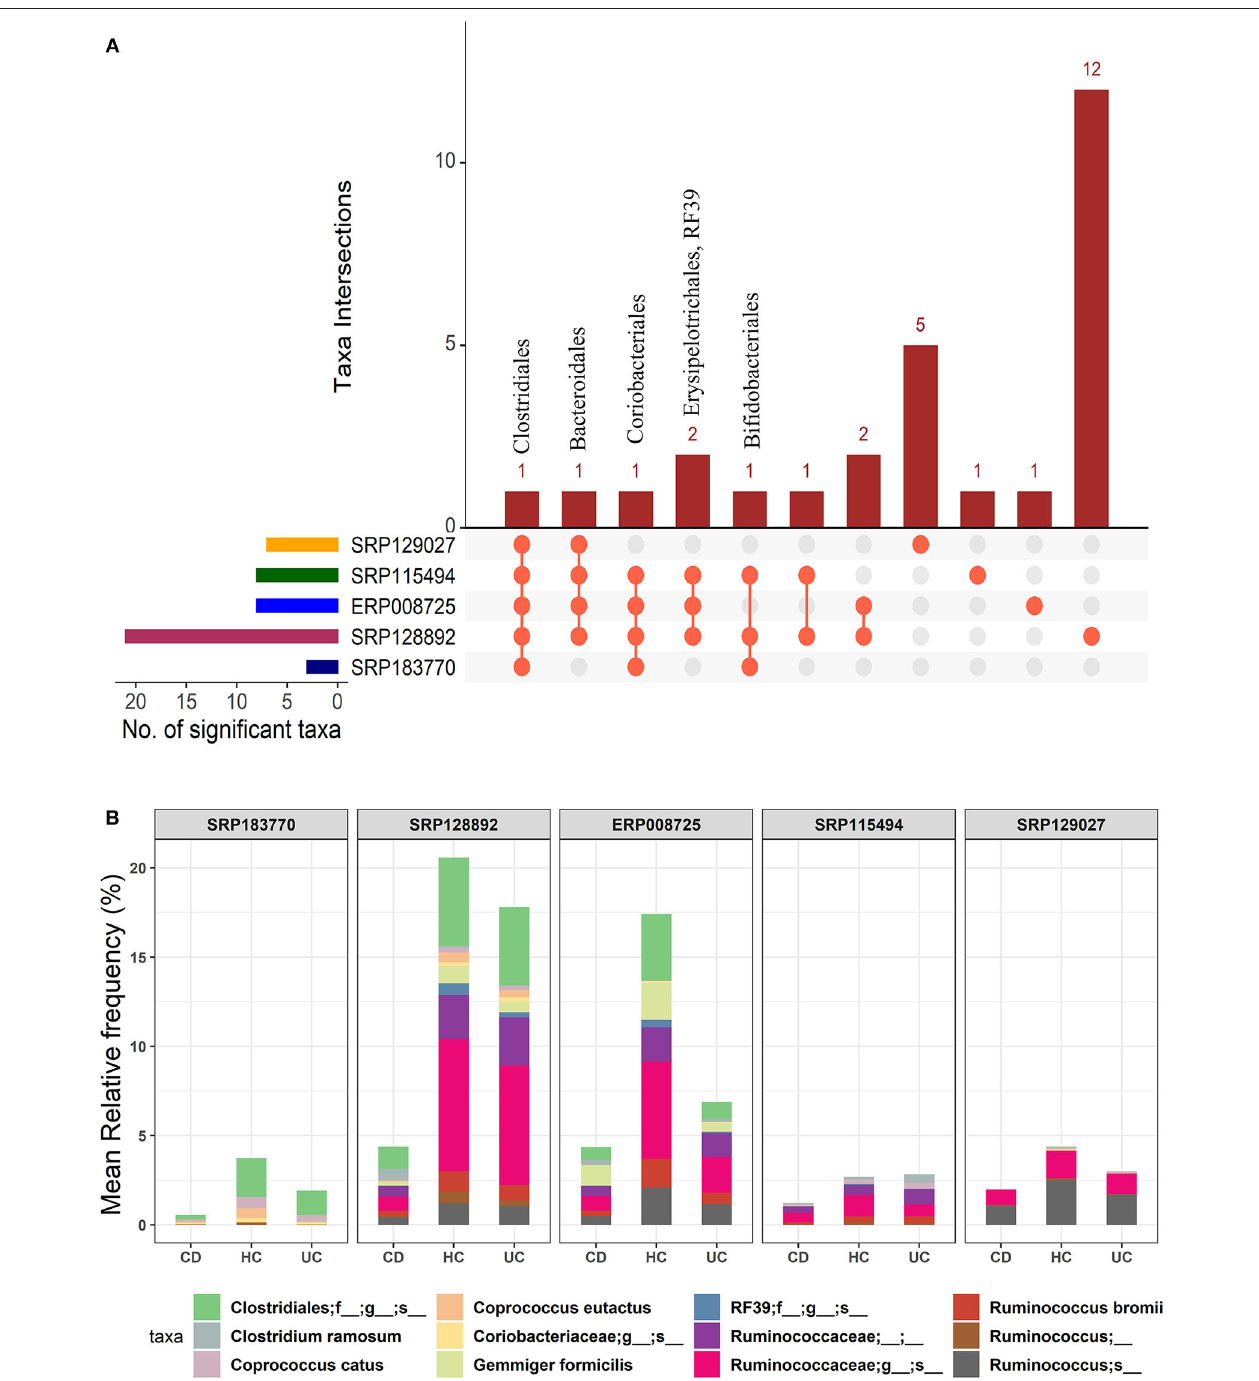
FIGURE 3 | Comparison of microbial communities among CD, UC, and HC cohorts across five datasets. (A) An upset plot showing taxonomic intersections across the five datasets at the Order-level. Each bar represents the number of orders in that category and the orange dot below the bar indicates their conservation across the datasets. For instance, members of Clostridiales are conserved in all five datasets; (B) Stacked bar plots show the relative mean frequencies of significant species-level communities in CD, HC or UC that are present in at least in three out of five datasets. Corresponding values are provided in the 168 OTUs sheet in Supplementary Datasheet 4 , where the columns contain data for five different